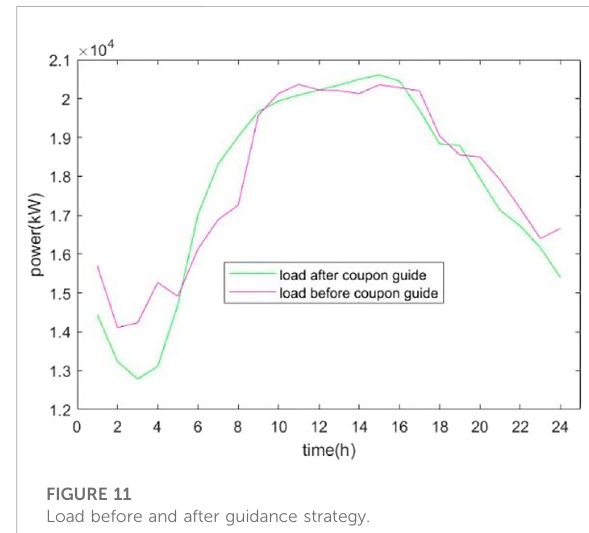
FIGURE 11 Load before and after guidance